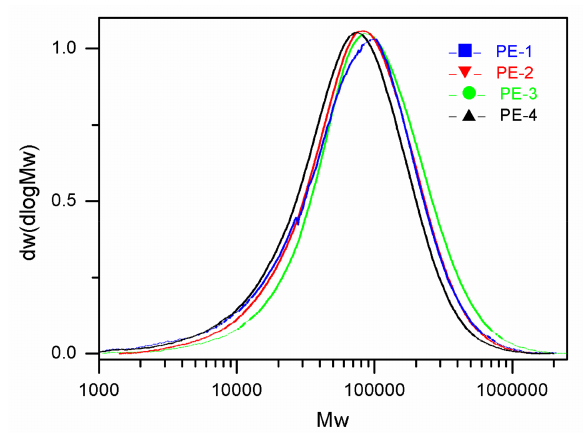
Figure 2. Curves of the molecular weight distribution of ethylene/1-hexene copolymers. (1) PE-1 obtained from BCZ/MAO@POP-1metallocene catalyst; (2) PE-2 obtained using BCZ/MAO@POP-2metallocene catalyst; (3) PE-3 obtained from BCZ/MAO@POP-6 metallocenecatalyst; (4) PE-4 obtained from BCZ/MAO@2408 silicametallocene catalyst.